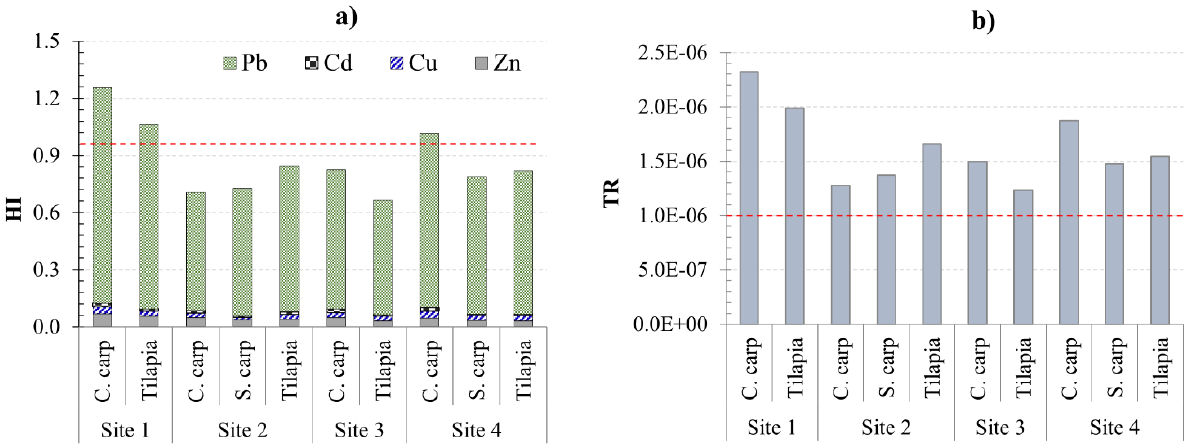
Figure 6. Year-average values for ( a ) the target hazard quotient (THQ) and the total hazard index (HI) of four tested metals; and ( b ) the target cancer risk (TR) posed by Pb in three fish species from four research sites. HI < 1 and TR < 1 × 10 − 6 , acceptable risk; HI > 1 and 1 × 10 − 6 < TR < 1 × 10 − 4 , potential risk.